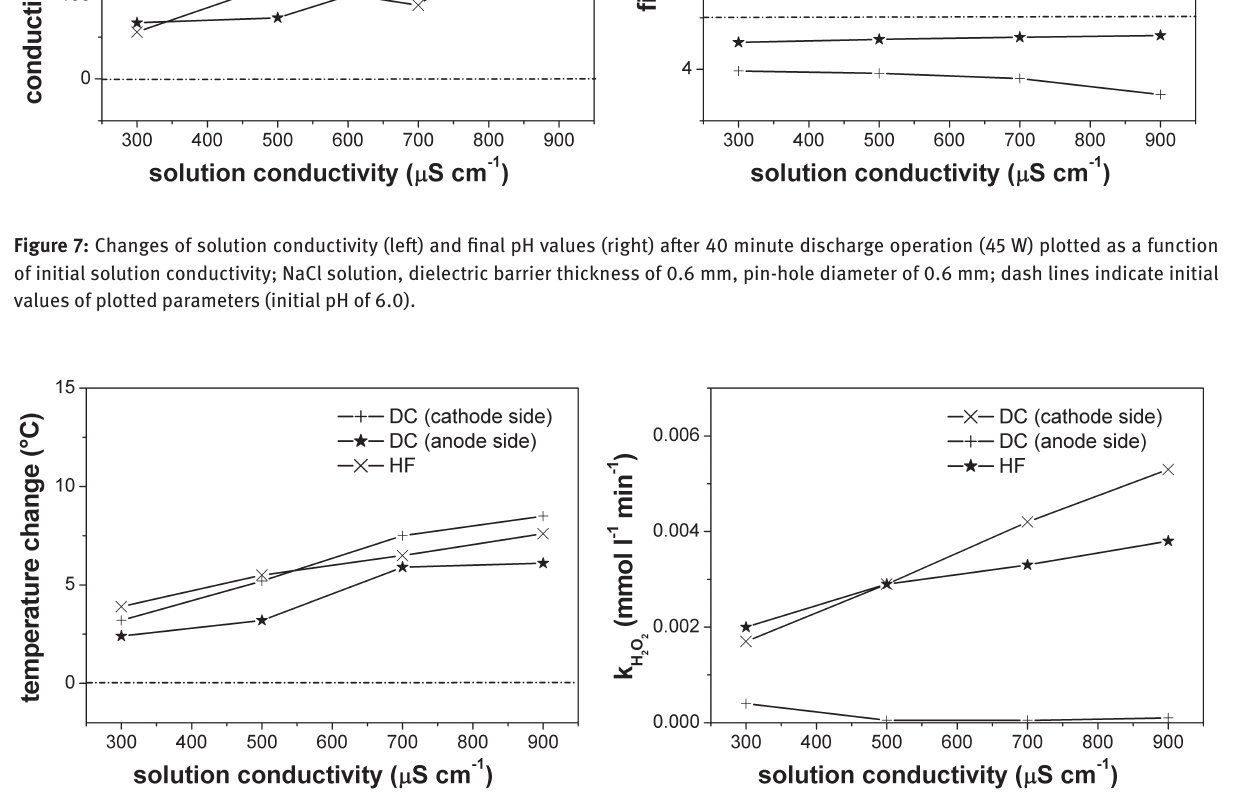
Figure 8: Change of temperature (left) and net production rate of hydrogen peroxide (right) after 40 minute discharge operation (45 W) plotted as a function of initial solution conductivity; NaCl solution, dielectric barrier thickness of 0.6 mm, pin-hole diameter of 0.6 mm; dash lines indicate initial values of plotted parameters (initial temperature of